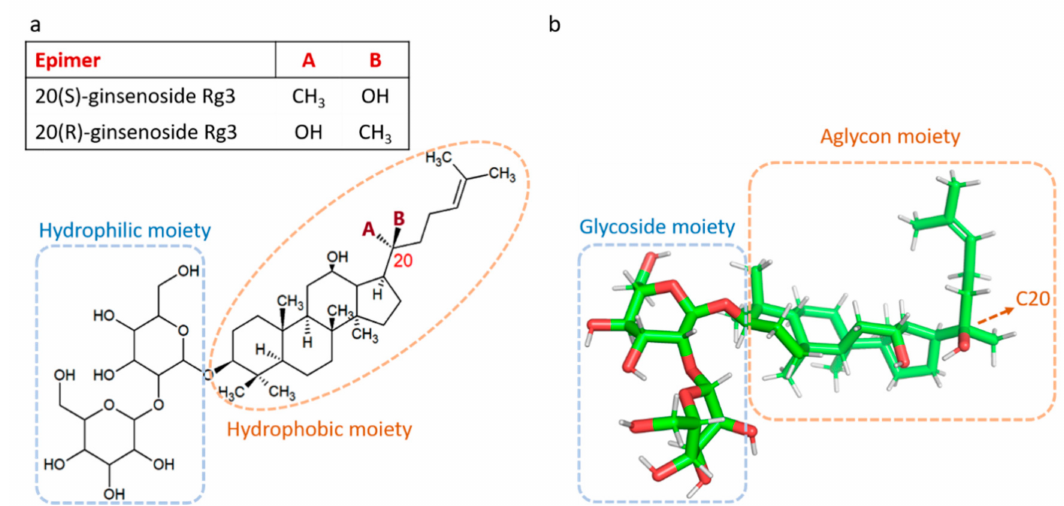
Figure 1. Structure of ginsenoside Rg3 as 2D ( a ) and 3D, generated in UCSF Chimera program ( b ), showing the chiral center at carbon 20, aglycone steroid-like backbone with hydrophobic properties and glycoside hydrophilic moiety, responsible for the water solubility of ginsenoside Rg3 (Rg3). Rg3 is one of the most studied and pharmacologically active ginsenosides, with